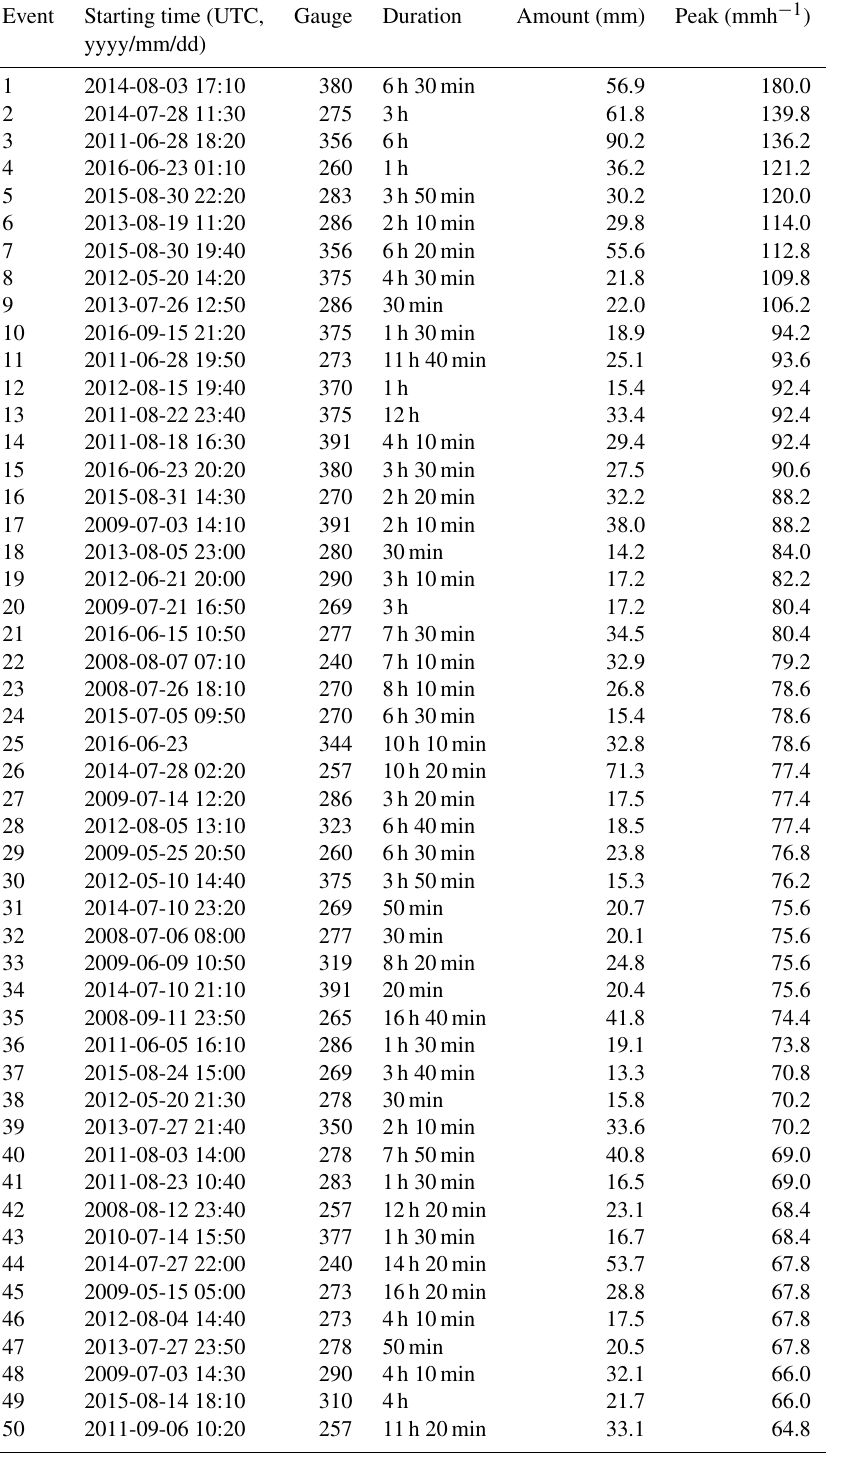
Table A2. Top 50 events for the